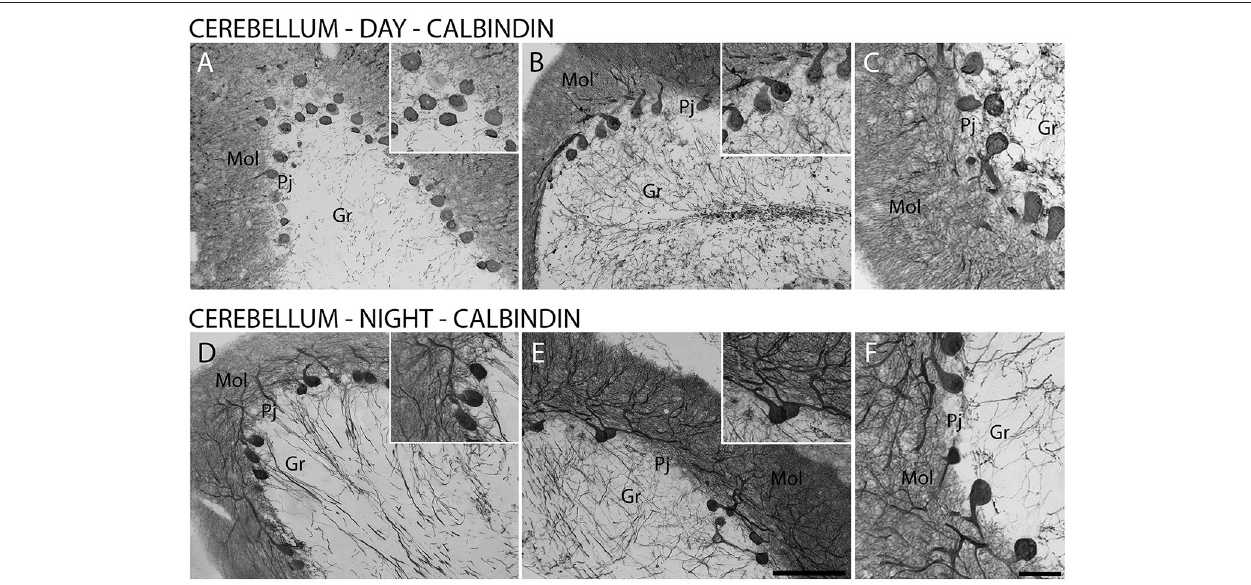
FIGURE 7 | The distribution of calbindin (CB) protein in the cerebellar cortex in the primate Sapajus apella . Photomicrographs of frontal brain sections show strongly stained CB-IR cells in Purkinje cell layer (Pj) (A–F) at two time points, one during the day (ZT 10) (A–C) and another at night (ZT 19) (D–F) . The CB-IR showed day/night variations in cell morphology in the Purkinje cell layer (D–F) . Bar = 100 or 50 µ m. Molecular layer (mol); granular layer